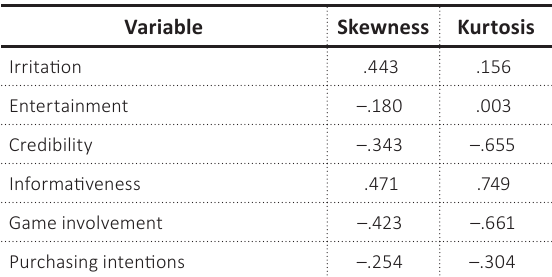
Table 8. Skewness and kurtosis values of each